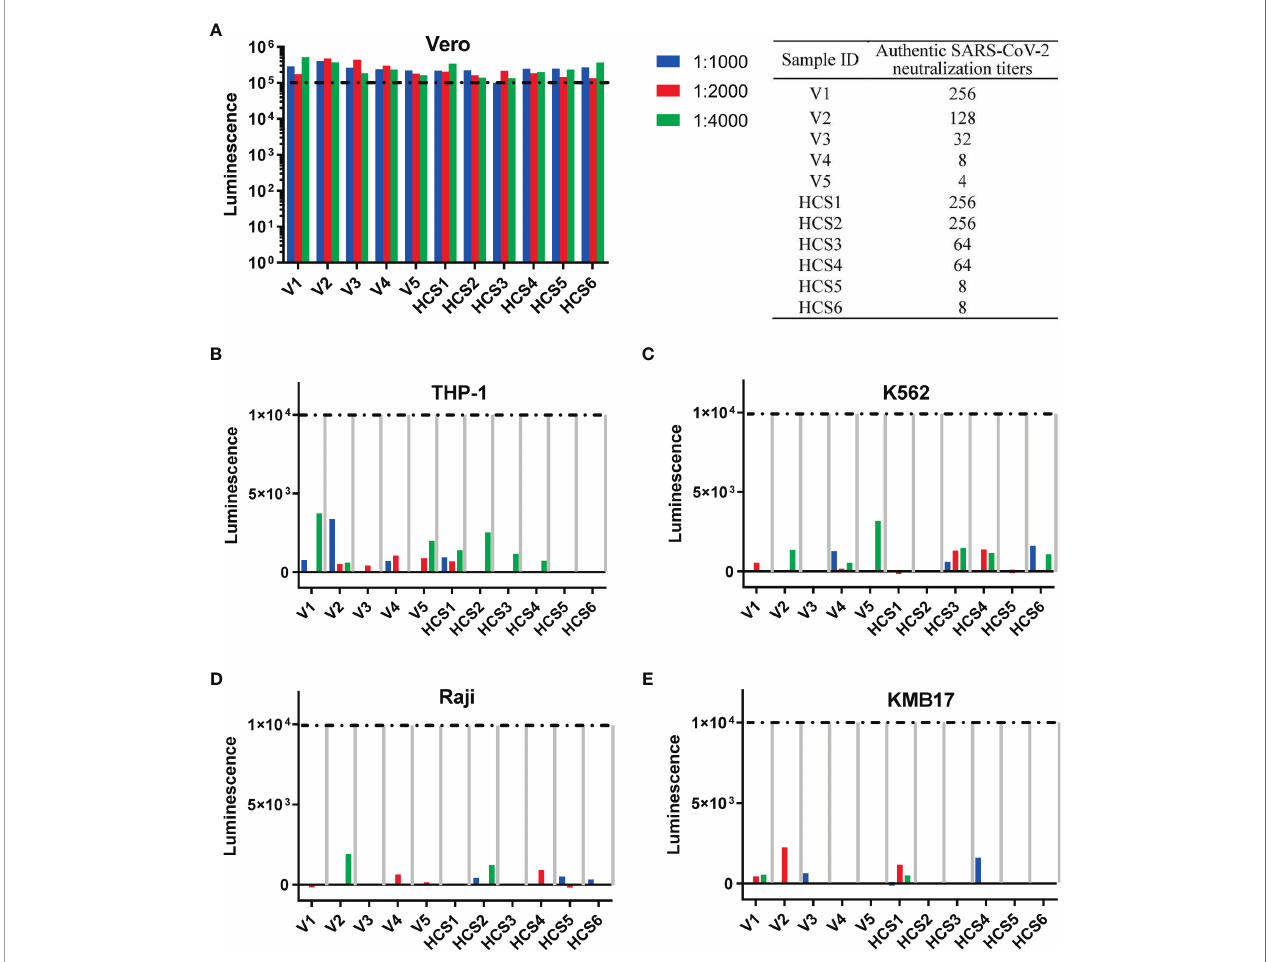
FIGURE 4 | Th2-oriented immune serum after SARS-CoV-2 inactivated vaccine administration does not enhance infection in vitro . (A) Pseudovirus-based neutralization assay of human serum with low to high authentic SARS-CoV-2 neutralization titers (from 4 to 256) in Vero cells that express ACE2. The sample ID and authentic SARS-CoV-2 neutralization titer are shown in the table on the right. (B – E) Assay of pseudovirus-based antibody-dependent enhancement of infection with human serum in cells with different Fc g R expression patterns. V1-V5, human sera after inactivated SARS-CoV-2 vaccination; HSC1-6: human convalescent serum. Each sample is shown